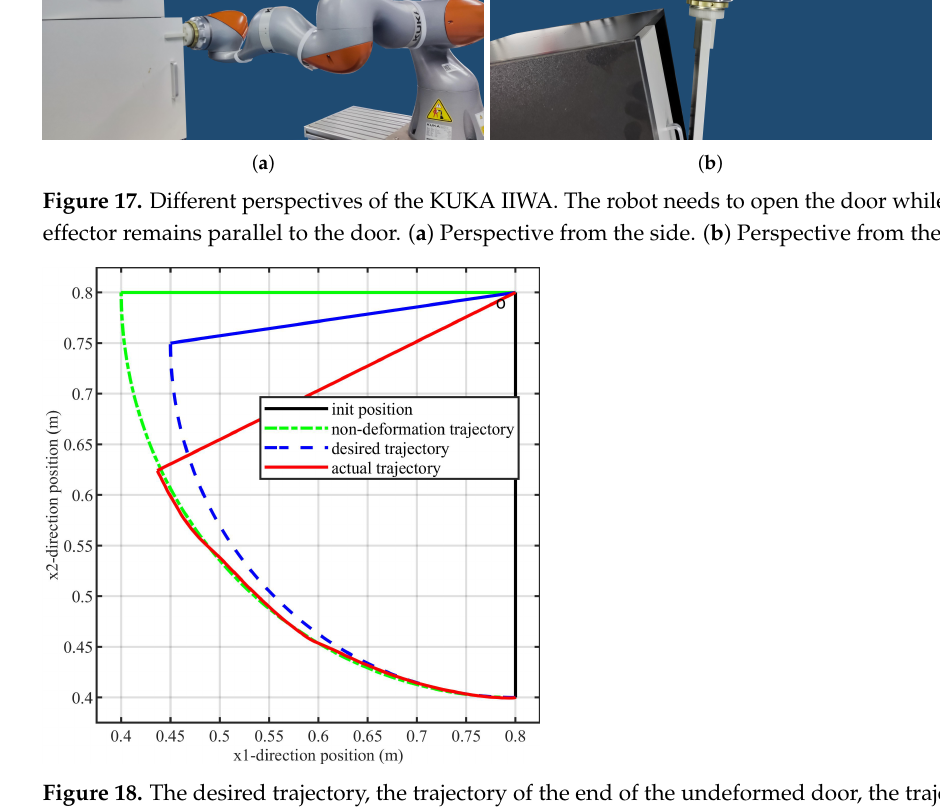
Figure 18. The desired trajectory, the trajectory of the end of the undeformed door, the trajectory of the KUKA IIWA robot’s end effector for the door-opening